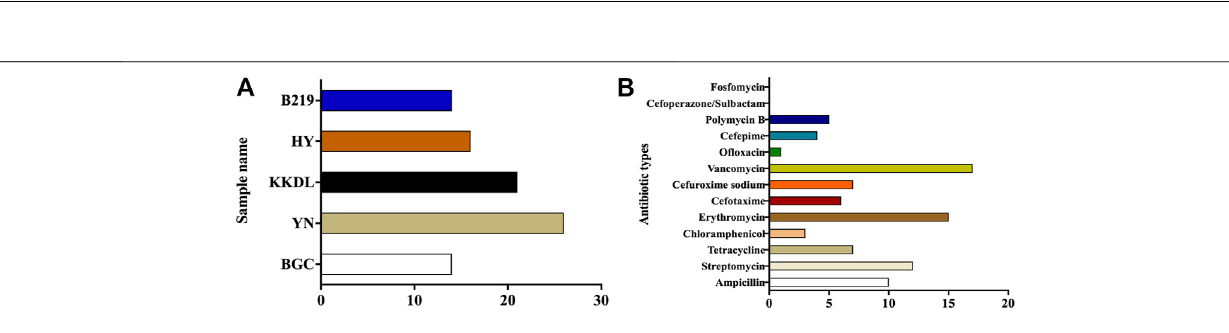
FIGURE 7 | Numbers of antibiotic-resistant bacteria. (A) The numbers of antibiotic-resistant bacteria in different sampling sites. (B) The numbers of bacteria resistant to different antibiotics.